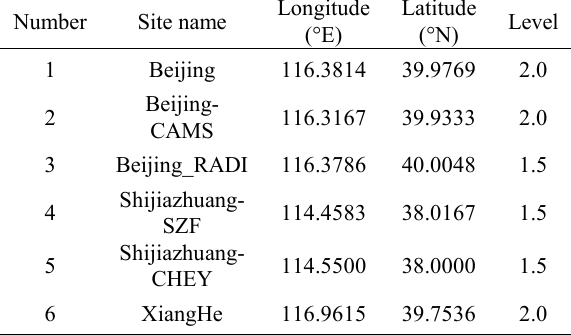
Table 1. Sites and data information of AERONET